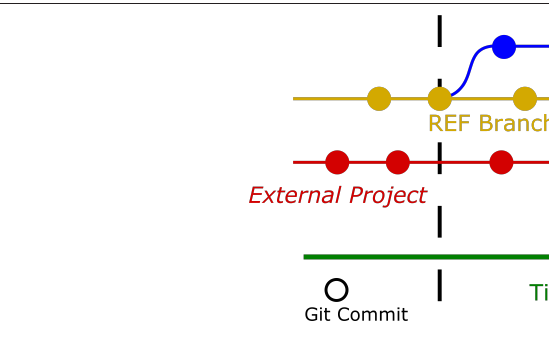
Figure 3. Evolution of git projects over time. Here a developer may want to commit a Merge Request (blue) to a Reference branch on a project (yellow) which depends on code from an external project (red). After the time of forking a MR it’s not possible to guarantee that the new code has not broken